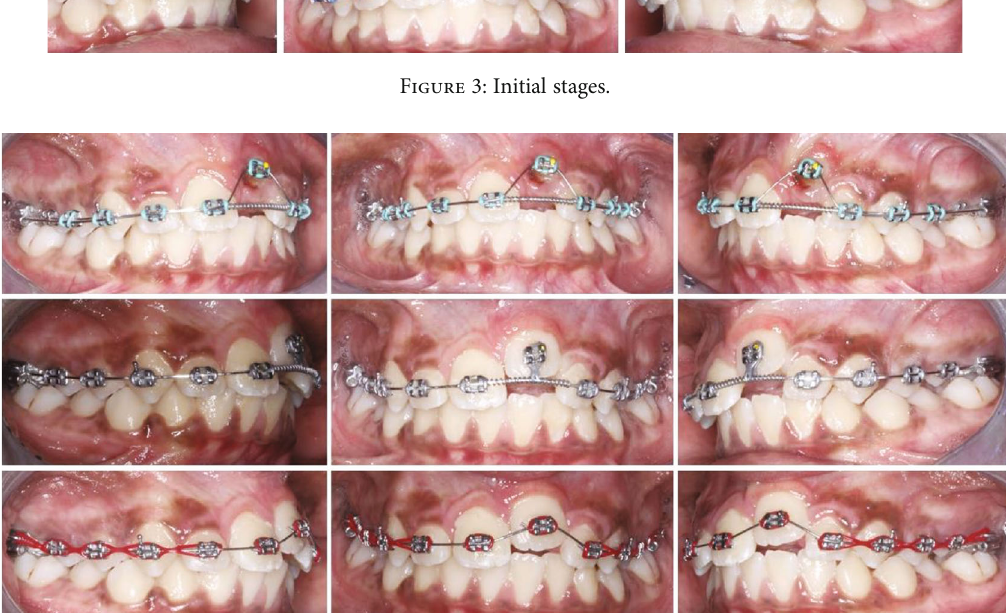
Figure 4: Treatment